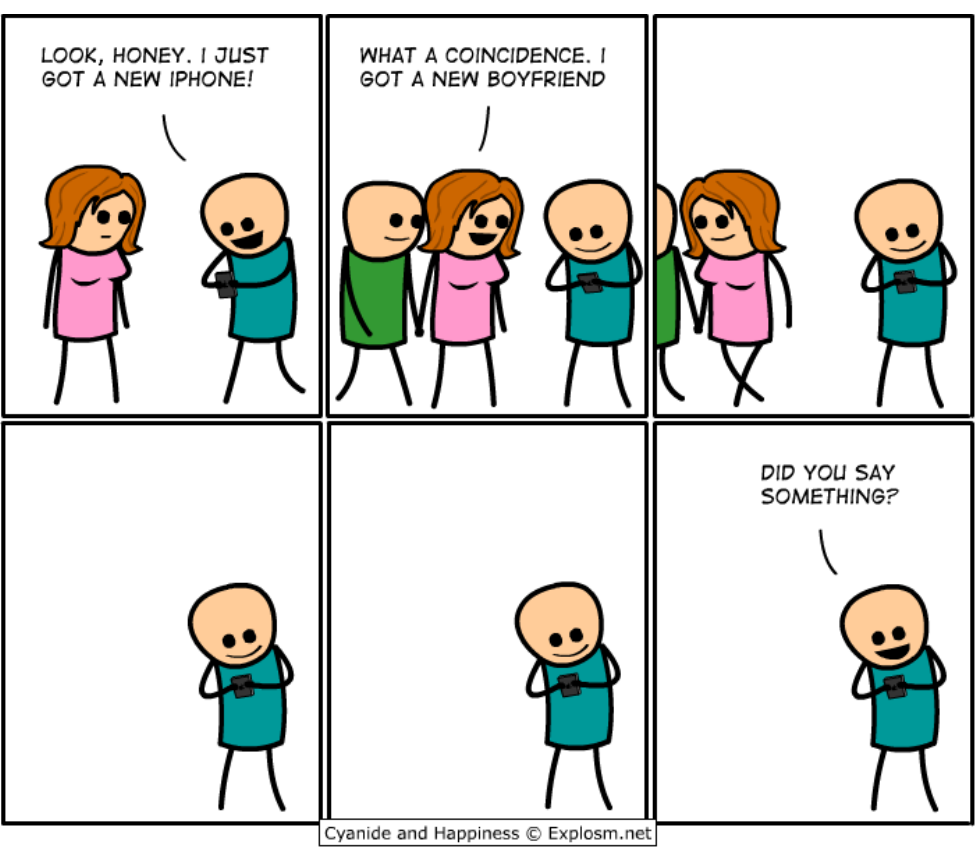
Figure 1. The popular Cyanide and Happiness cartoon (DenBleyker 2010) relies on the reader seeing both hands holding a smartphone as a manifestation of strong smartphone engagement.